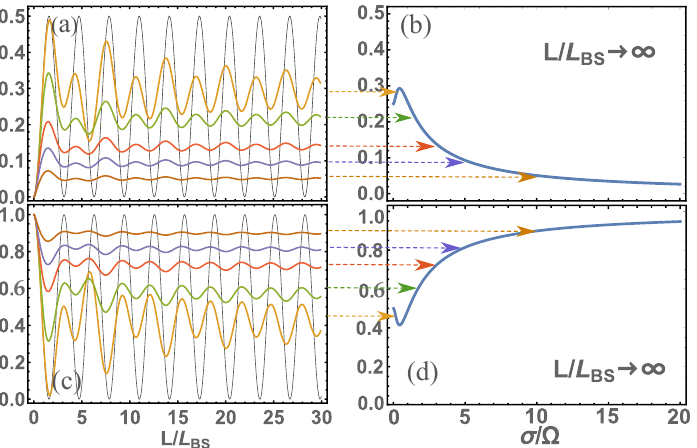
Figure 2. The calculation is presented: ( a ) probabilities P 0,2 of detecting 2 photons at the second detec- tor and 0 of photons at 1 detector (with P 0,2 = P 2,0 ) at different parameters σ / Ω = { 0,1/2,3/2,3,5,10 } (respectively, the color of the graphs in the figure: { black, yellow, green, red, blue, brown } ) depending on the dimensionless BS length L / L BS ; ( b ) the same but with larger dimensions of the beamsplitter, i.e., at L / L BS → ∞ ; ( c ) the same as in ( a ) but only for the probability P 1,1 of one photon detected at each detector; ( d ) the same as in ( b ) but only for the probability P 1,1 .